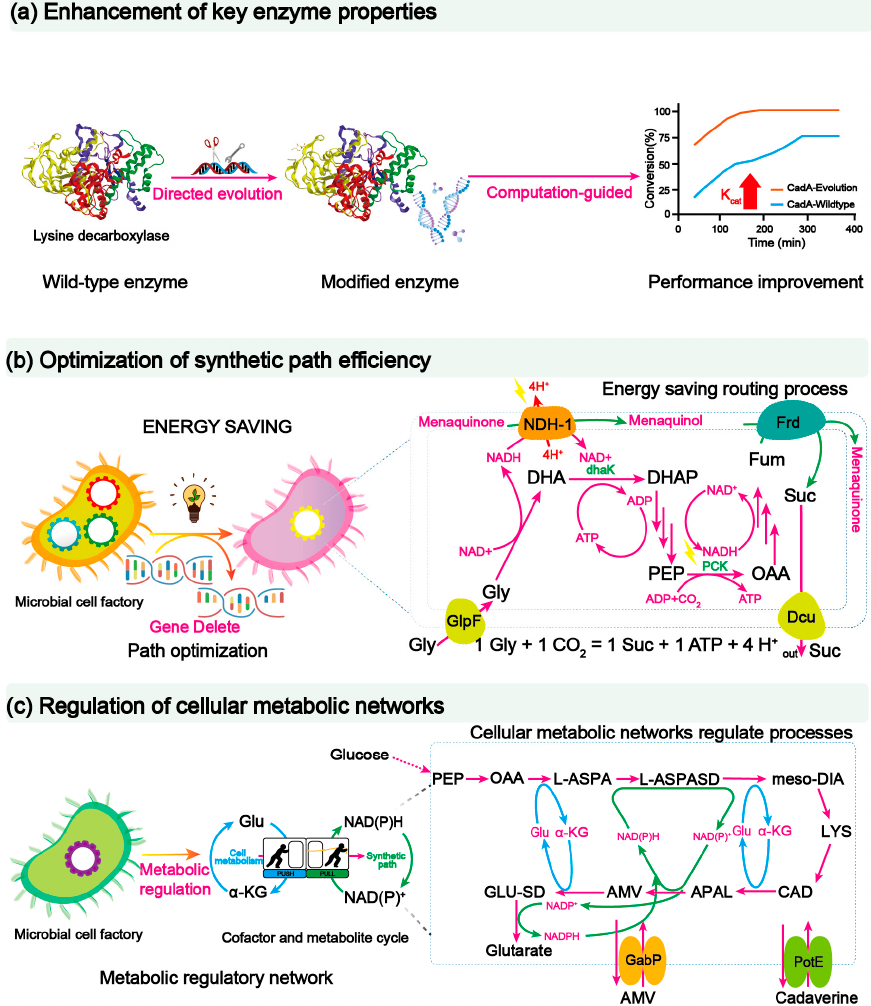
Figure 3. Strategies for improving synthesis efficiency. ( a ) Aiming at the problem that lysine decar- boxylase is not resistant to an alkaline pH environment, directional evolution is introduced to improve the catalytic efficiency of the process and strengthen the performance of L-lysine decar- boxylase. ( b ) The growth of E. coli and the synthesis of succinic acid were improved by constructing a glycerol metabolic pathway with low energy requirements, and the efficiency of the synthetic pathway was increased. Abbreviations: DhaK, ATP-dependent dihydroxyacetone kinase; PCK, phosphoenolpyruvate carboxykinase; Frd, fumarate reductase; Dcu, anaerobic C4-dicarboxylate transporter Dcu; NDH-1, NADH: ubiquinone oxidoreductase I; GlpF, glycerol facilitator; DHA, dihydroxyacetone; DHAP, dihydroxyacetone 3-phosphate; PEP, phosphoenolpyruvate; OAA, ox- aloacetate; Fum, fumarate; Suc, succinate; Gly, glycerol. ( c ) Based on the metabolic drive